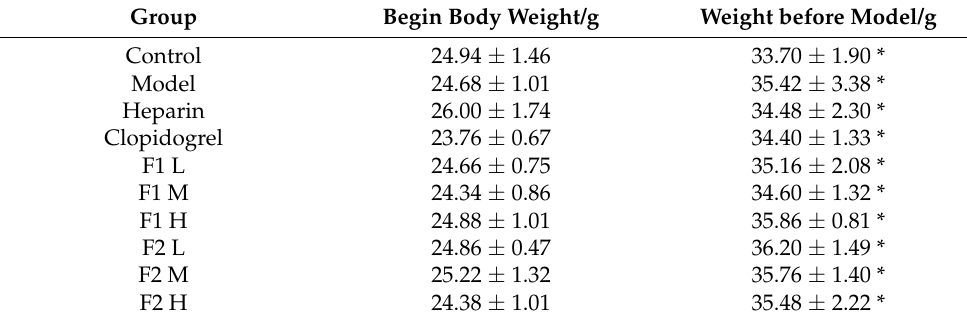
Table 5. The change in mice body weight ( n = 6).